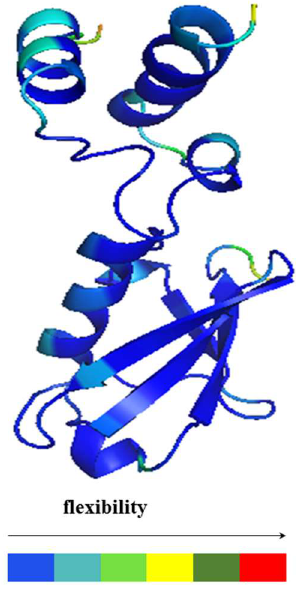
Figure 16. Internal flexibility of the CUBAN/NEDD8 complex obtained by molecular dynamic simulation, superimposed to the structure as obtained by NMR spectroscopy (25808 and 2n7K) [14]. The differences in the backbone flexibility of the molecular moieties are visualized by color scale.